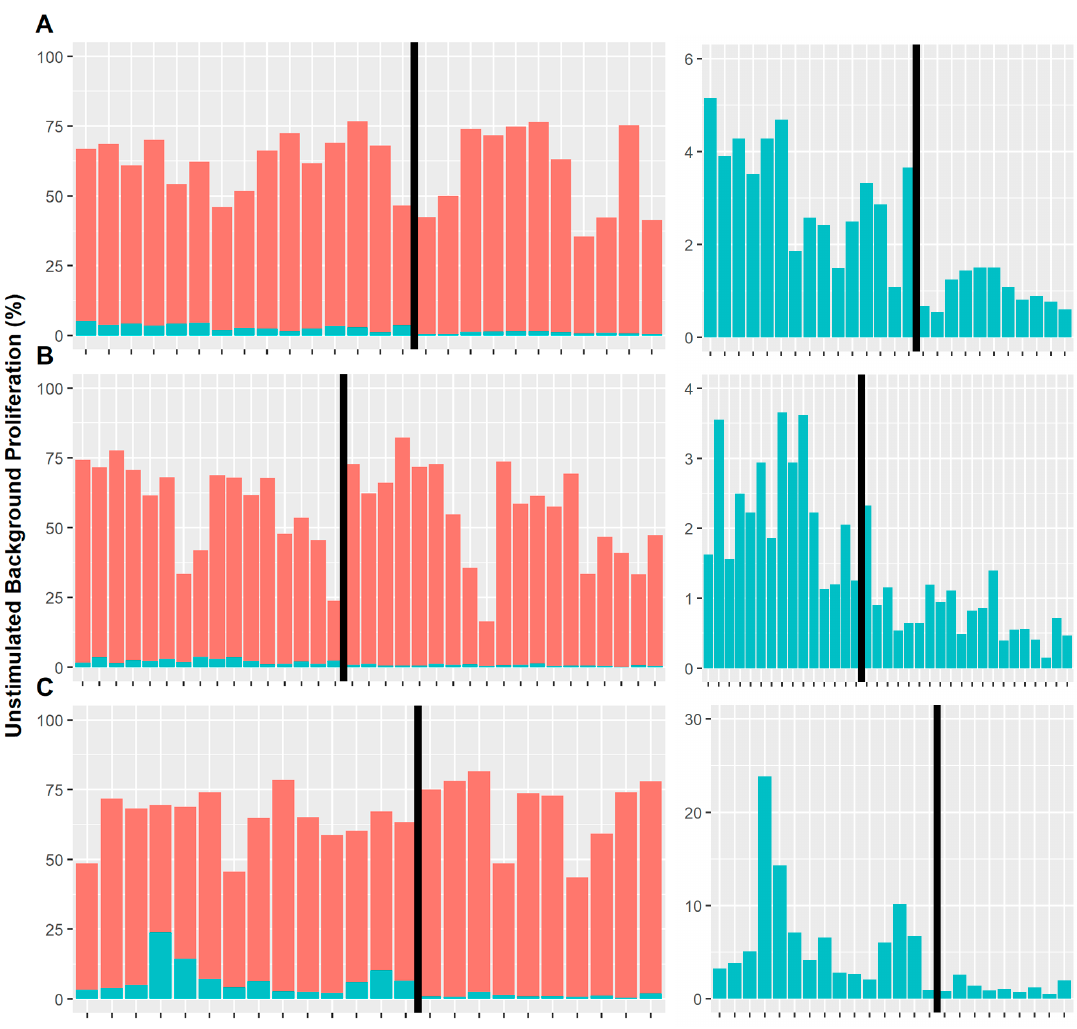
Figure 6. Background proliferation responses of IgM − (red) and IgM+ (blue) lymphocytes for individual smallmouth bass ( Micropterus dolomieu ) collected from Cheat River ( A ), South Branch at Petersburg, WV ( B ), and South Branch at Moorefield, WV ( C ). The vertical line separates samples collected in spring (left) and fall (right). The graphs on the right are zoomed in to show the percentages for IgM+ lymphocytes (blue).